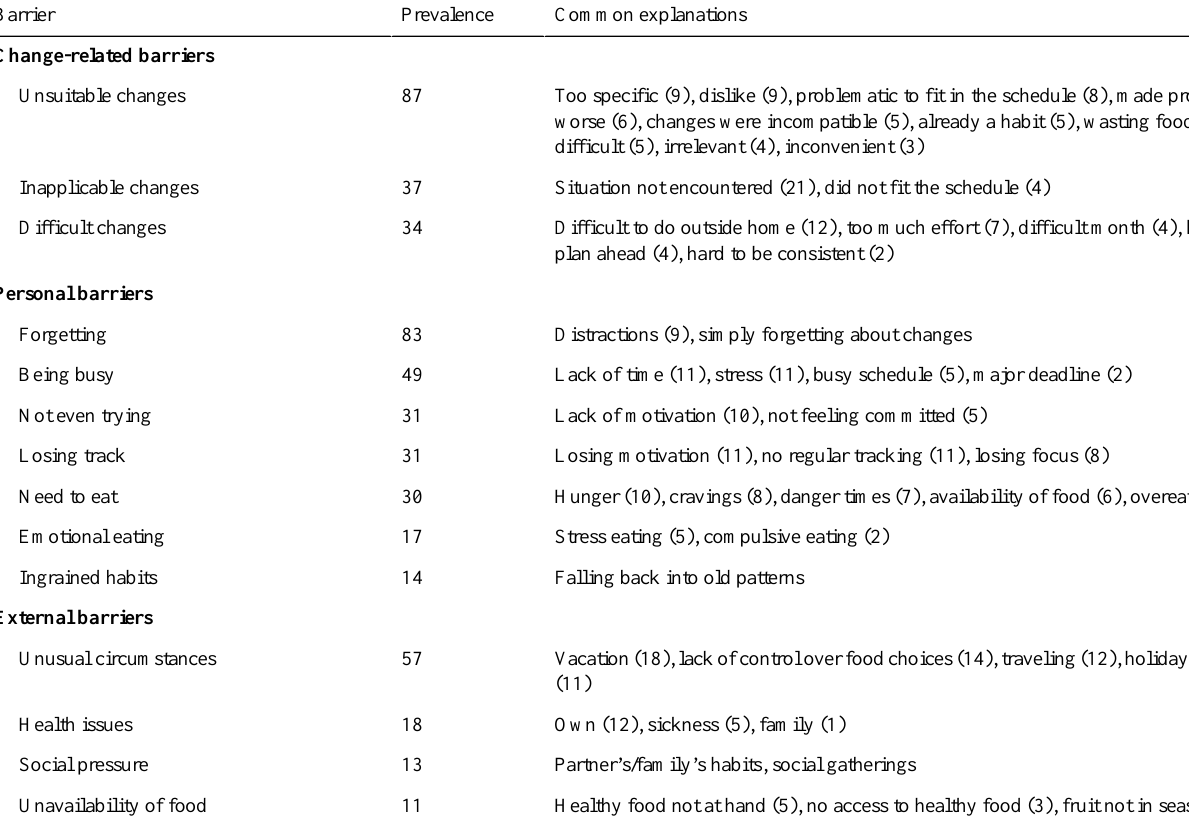
Table 5. Common barriers to changes based on participants’experiences.